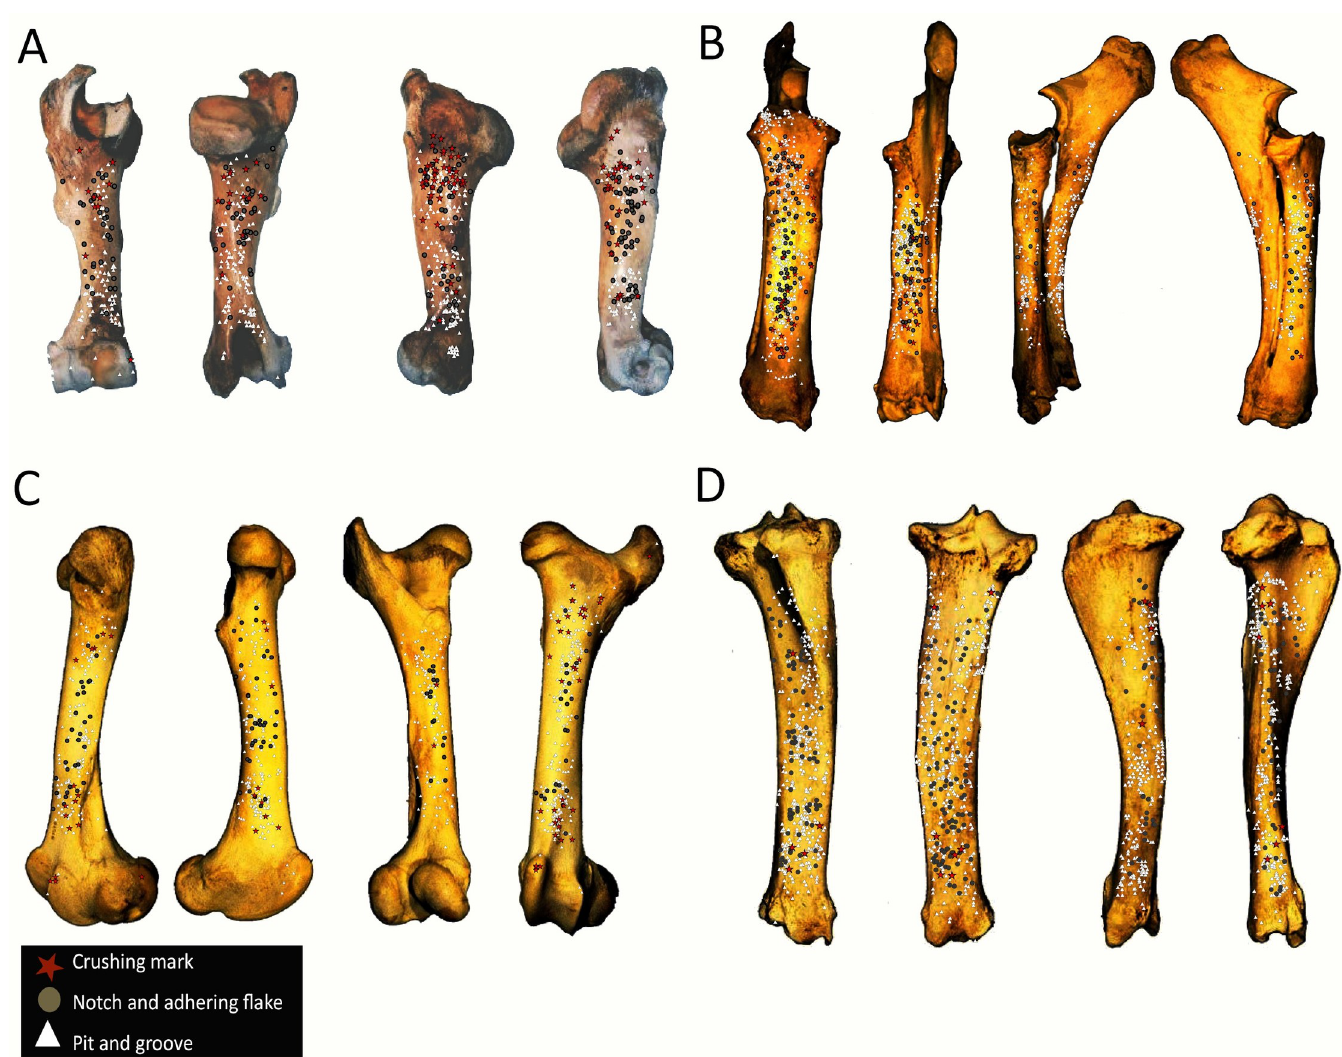
Fig 4. Distribution of percussion marks of individual series merged along the humerus, the radio-ulnas, femurs and tibias. The type of percussion mark are red star: crushing marks, white triangle: pits and grooves and grey circle: notches and adhering flakes.